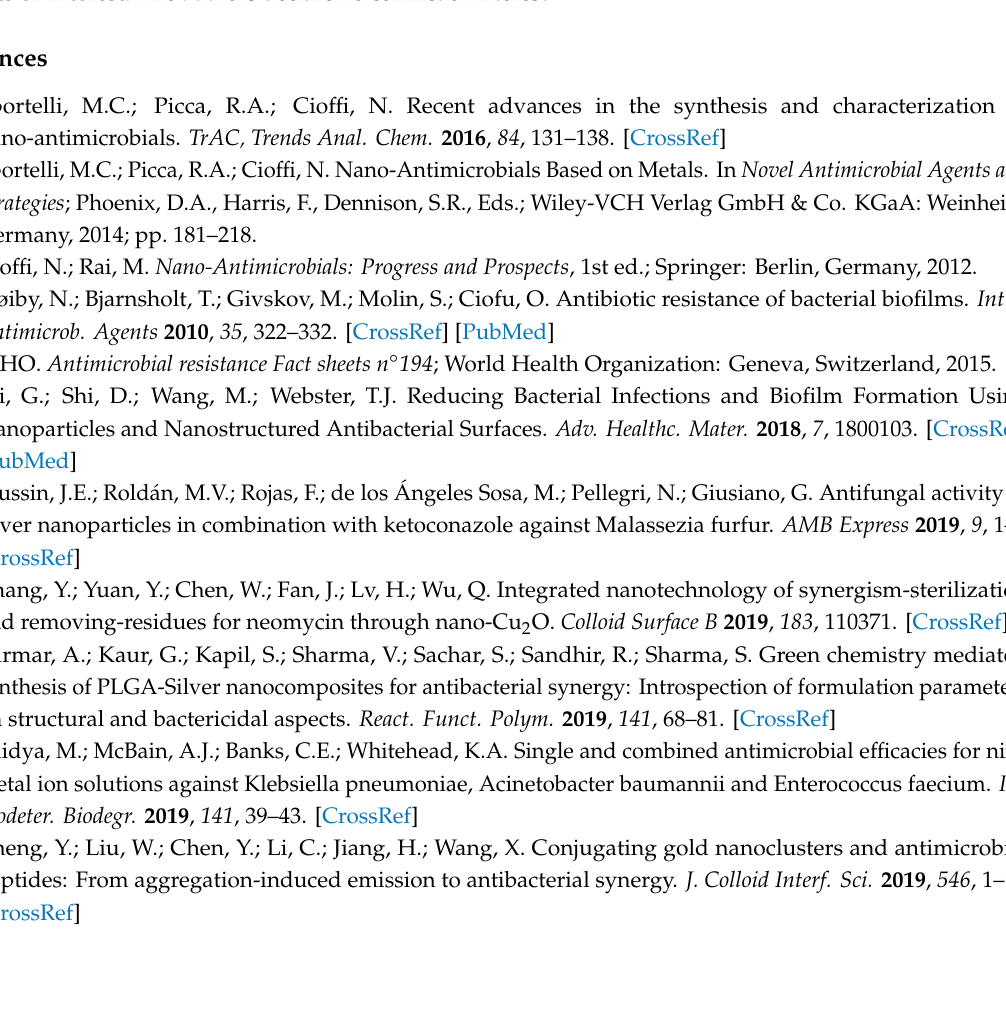
Supplementary Materials: The following are available online, Table S1: CuNPs@BAC morphological results obtained varying the electrochemical parameters during the preparation process, Table S2: AgNPs and CuNPs concentrations in the liquid G medium. Initial concentration was 10 -4 g / mL ( = 100 µ g / mL), Table S3: Plateau values for copper release from three types of fabrics modified by CuNPs@BAC nanoparticles at two di ff erent CuNPs